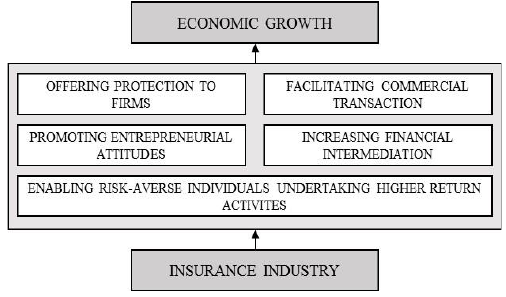
Figure 1. The Relationship Pattern between Insurance Sector and Economic Growth (Adapted from Brainard (2008); Cristea et al . (2014); and Peleckienė et al .